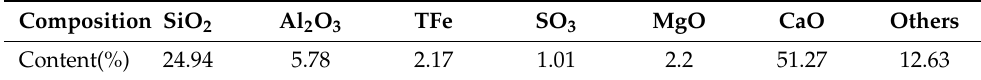
Table 2. Chemical composition of the